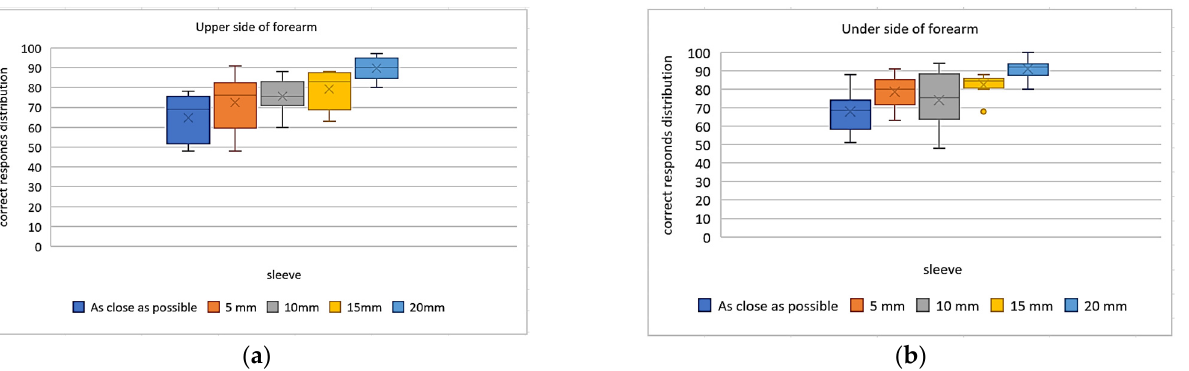
Figure 5. Box–whisker plot comparing the accuracy (percent correct, y -axis) between the five differ- ent tactile sleeves with various inter distances between enclosures ( x -axis): ( a ) the percent correct for the upper side of the forearm; and ( b ) the percent correct for the underside of the forearm. The box length represents the interquartile range (IQR), the 25% and the 75% limits, and the horizontal bar inside the box shows the median value. The ends of the box plot represent minimum and maximum values.